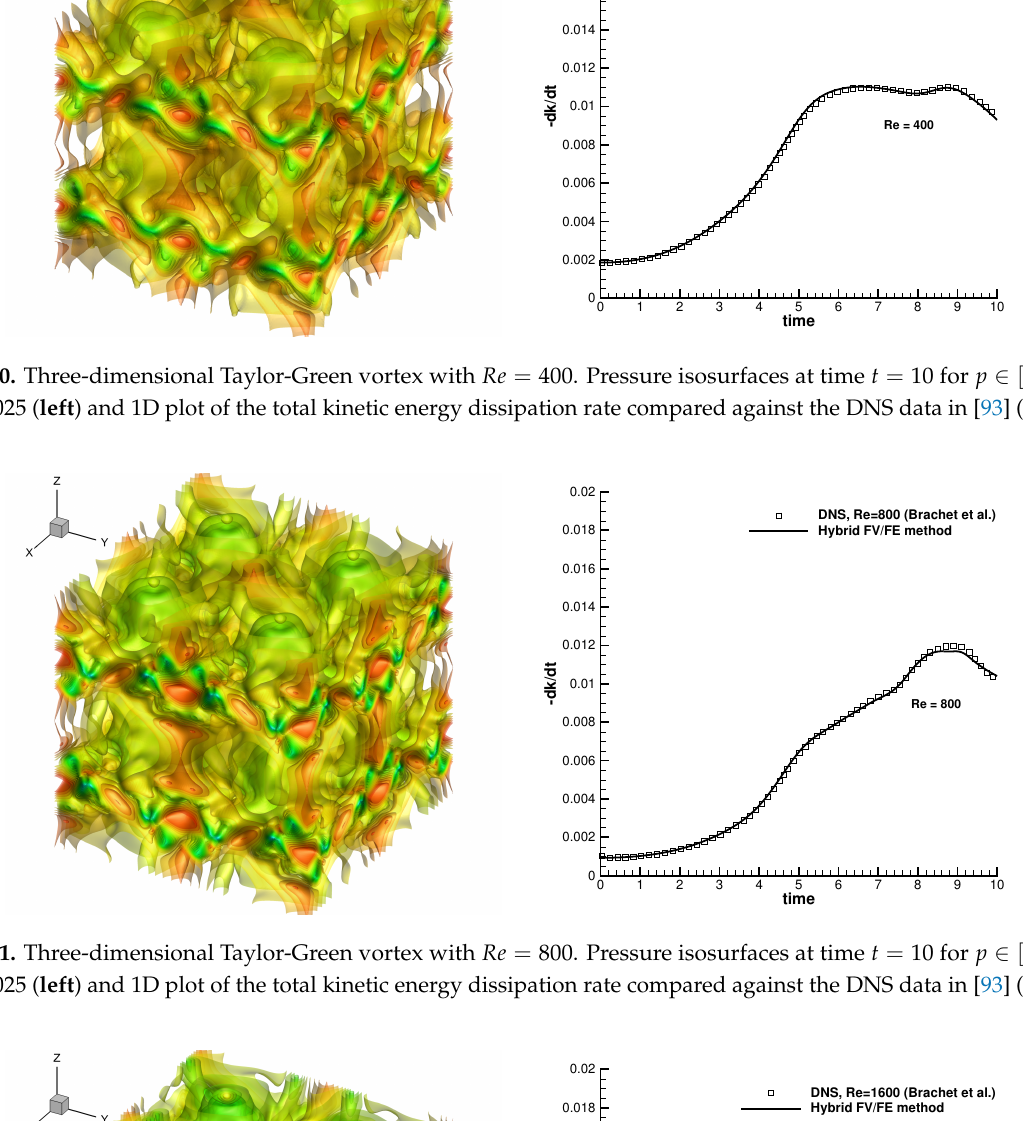
Figure 11. Three-dimensional Taylor-Green vortex with Re = 800. Pressure isosurfaces at time t = 10 for p ∆ p = 0.025 ( left ) and 1D plot of the total kinetic energy dissipation rate compared against the DNS data in [93] ( right ).